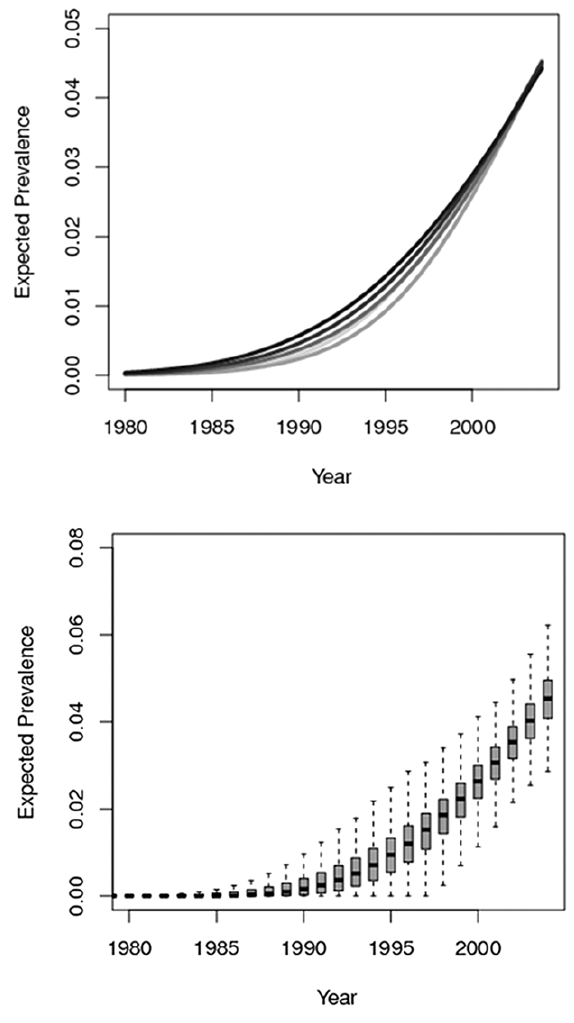
Figure 2. The expected percent of study participants infected over each calendar year back to 1980. A. The expectation for models with 2,4,6,8 and 10 epicenters; lines are shaded according to the number of epicenters (2 epicenters-light grey, 10 epicenters=black). B. A boxplot showing the median and credible intervals for the posterior estimates from the best-fit four-epicenter regression model. Chagas disease is a lifelong infection; infected individuals are assumed to remain seropositive through their